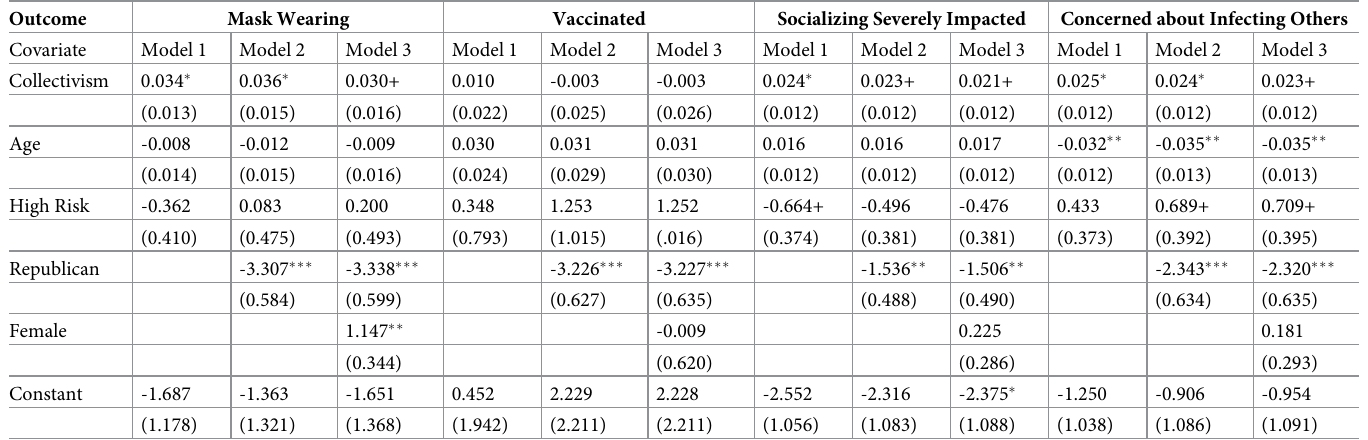
Table 3. Logistic regression on COVID behaviors by collectivism (N = 251).